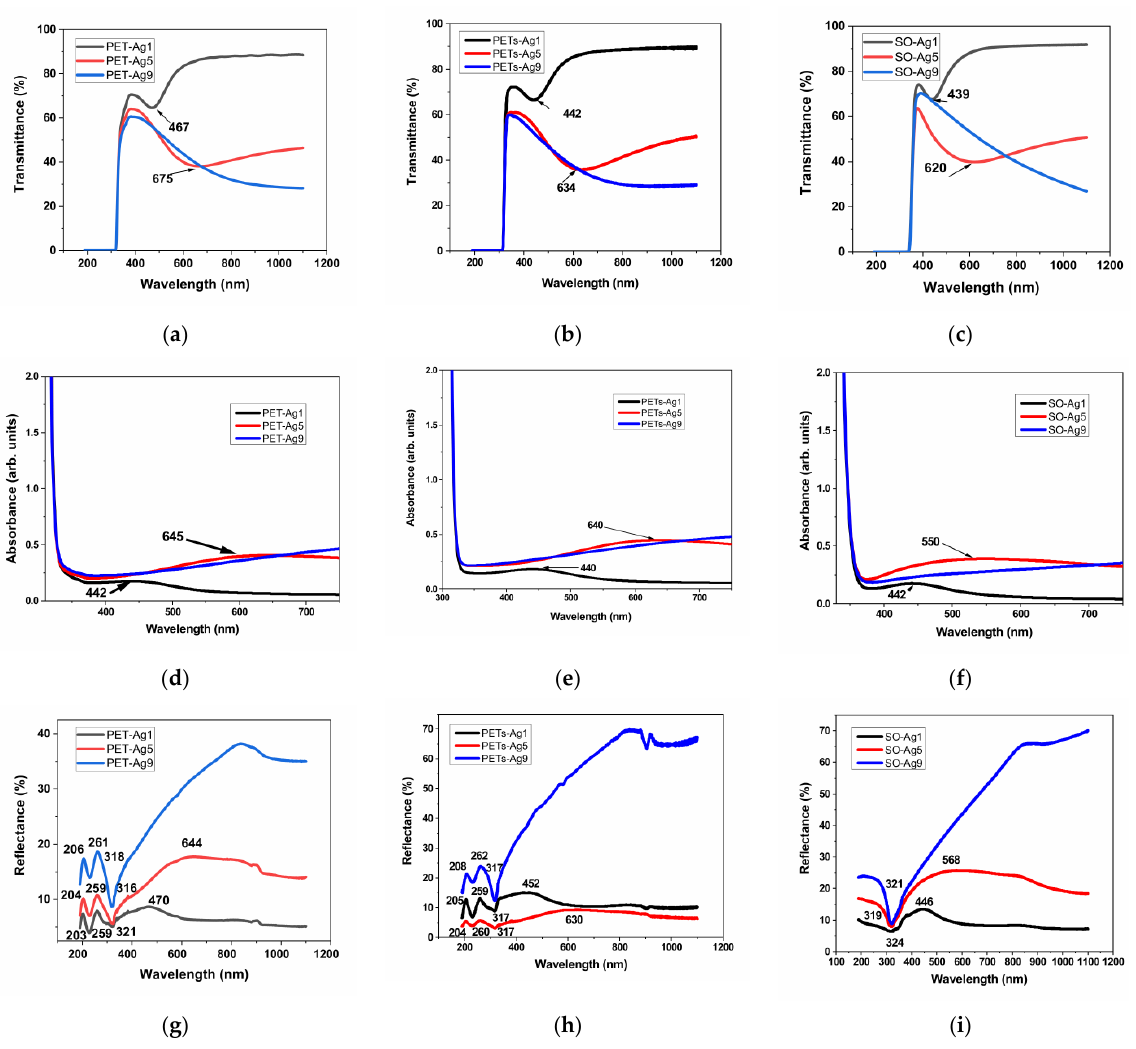
electrical conductivity [13] , and SPR properties.